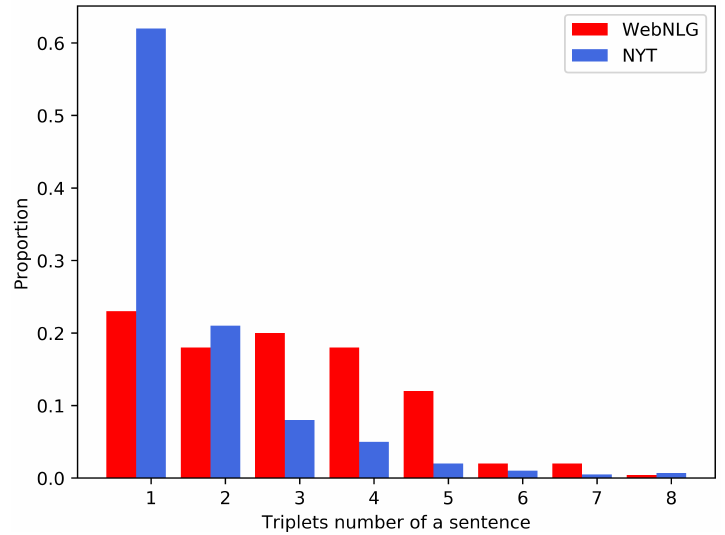
Figure 7. Distribution of the number of triplets in two datasets.